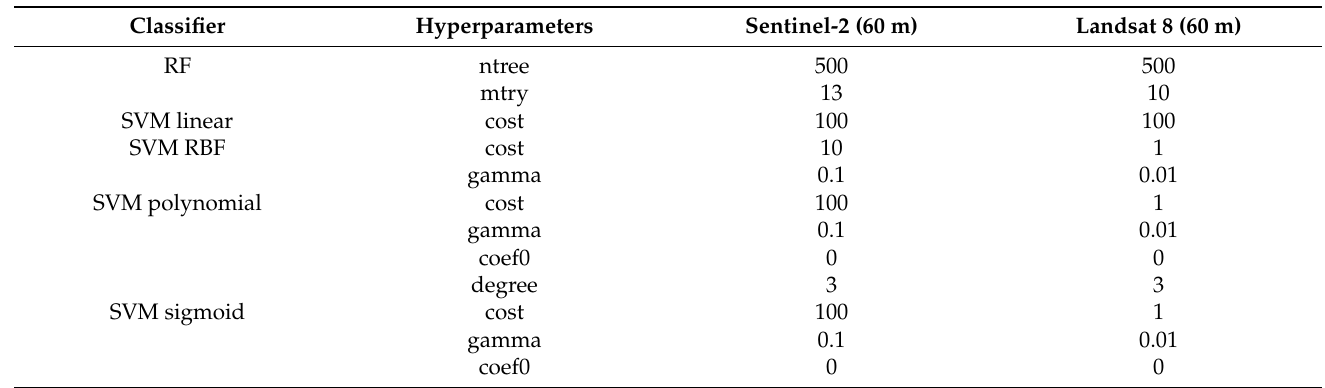
Table 4. Optimized parameters of the